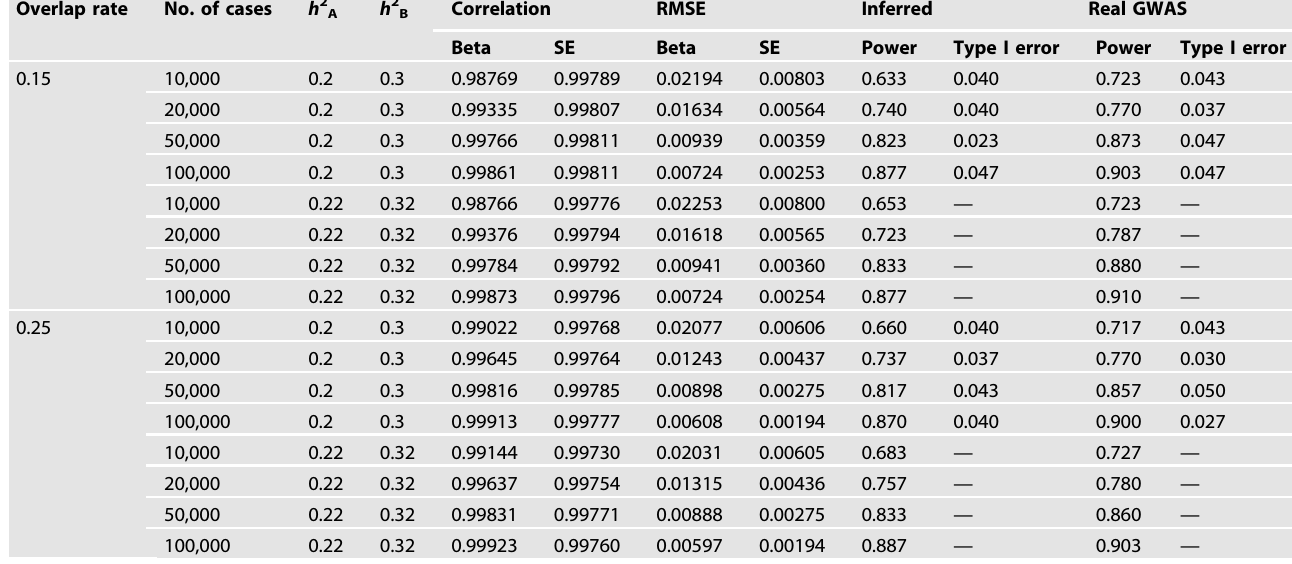
Table 2. Simulation results comparing analyses of individual-level genotype data and our presented analytic approach. Overlap